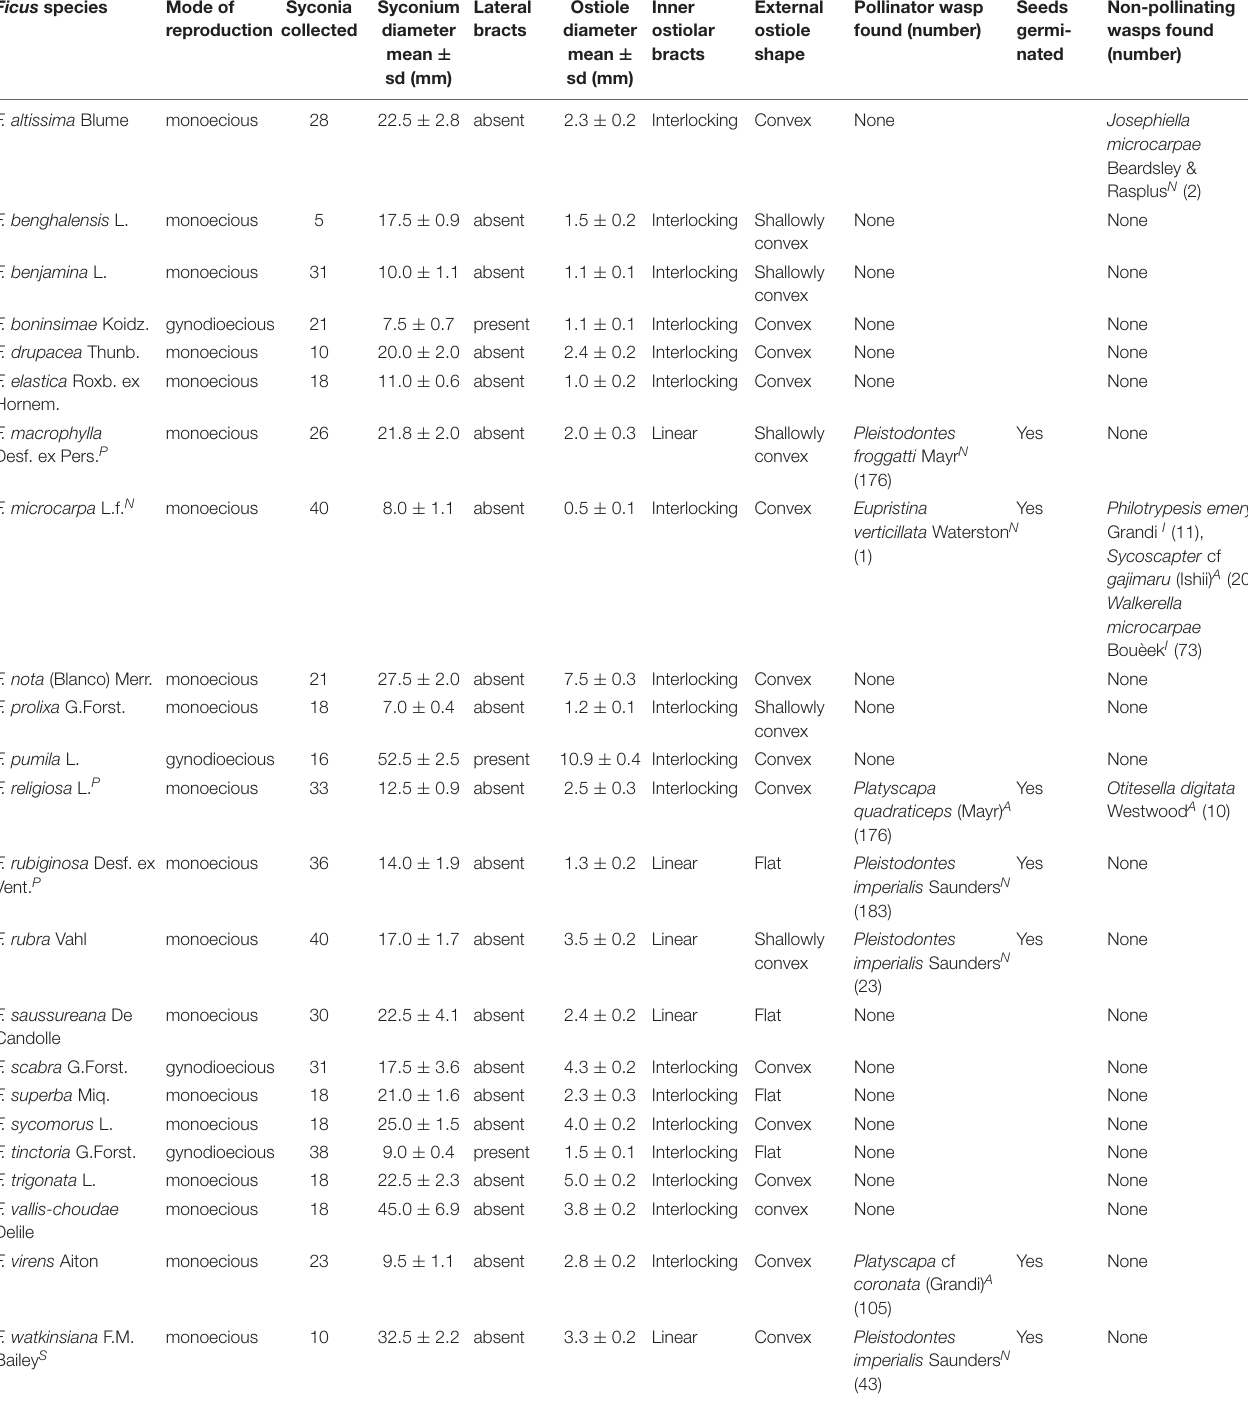
TABLE 1 | Morphometric and seed germination data for non-native fig species on Kauai, alongside any wasps present; metrics in mean ± standard deviation; N = previously known naturalized species; A = new naturalization record for the Hawaiian archipelago; I = new naturalization record for Kauai Island but known on other Hawaiian islands; P = new potentially naturalizing species on Kauai; S = species outside of cultivation but without self-sustaining wild populations (see details in Supplementary Material ). Ficus species Mode of Syconia Syconium Lateral External Pollinator wasp Seeds reproduction collected diameter bracts ostiole found (number) mean ± bracts shape sd (mm)